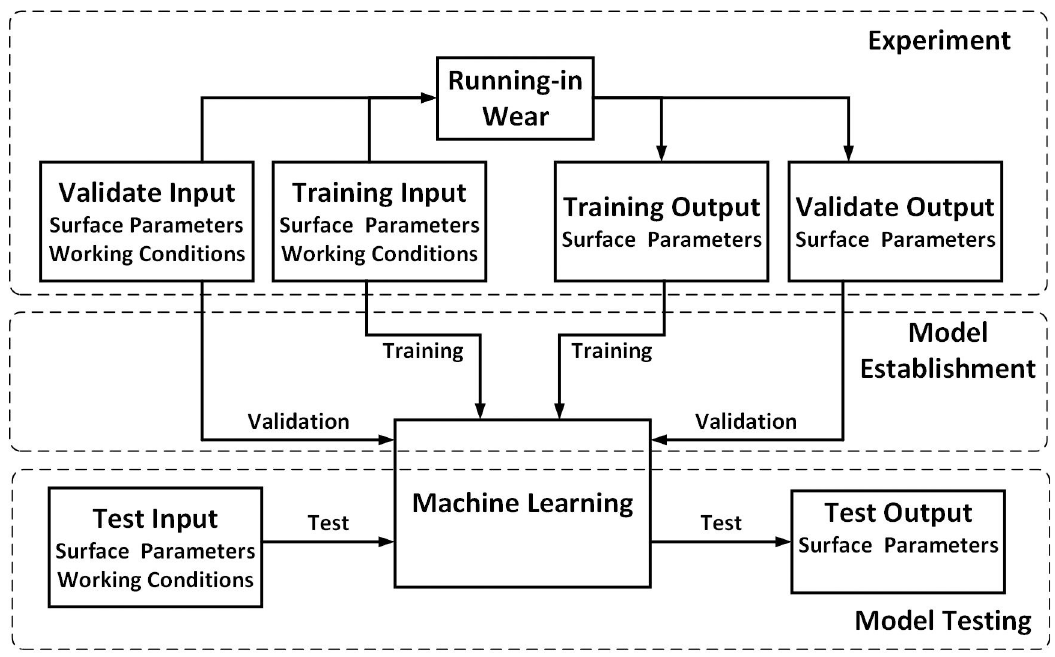
Fig 5. Establishment of running-in wear prediction model based on